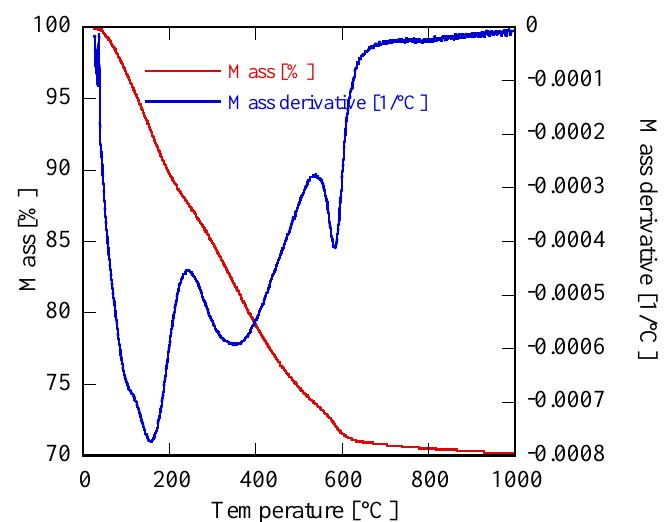
Figure 3. Thermogravimetric (TG) and TG derivative of sample Yb48hR10.